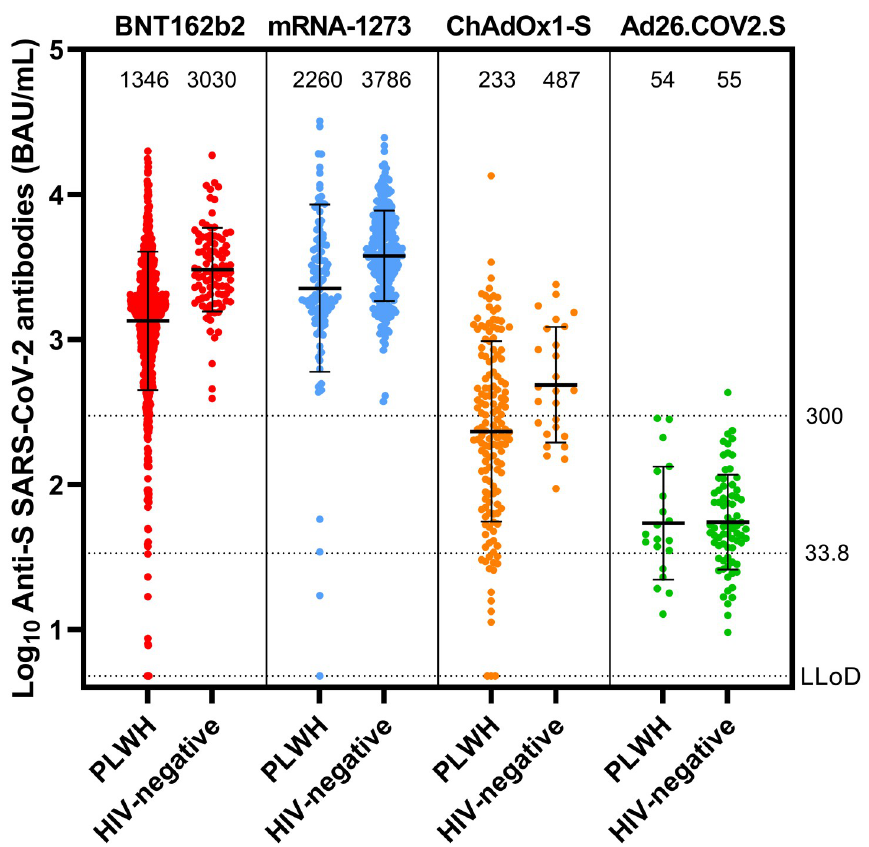
Fig 2. Antibody concentration in PLWH and controls after vaccination. Anti-spike SARS-CoV-2 binding antibodies after BNT162b2 (HIV-negative, n = 94; PLWH, n = 884), mRNA-1273 (HIV-negative, n = 247; PLWH, n = 100), ChAdOx1-S (HIV-negative, n = 26; PLWH, n = 150), or Ad26.COV2.S (HIV-negative, n = 73; PLWH, n = 20) vaccination in PLWH and the HIV-negative control group. The thick horizontal bar shows the geometric mean concentration, also indicated in the numbers above the graphs, with error bars showing geometric standard deviation. The dotted lines show the lower limit of detection of the performed test (4.81 BAU/mL), the positivity cutoff (33.8 BAU/mL), and the hyporesponse cutoff (300 BAU/mL). BAU, binding antibody units; LLoD, lower limit of detection; PLWH, people living with HIV; S,